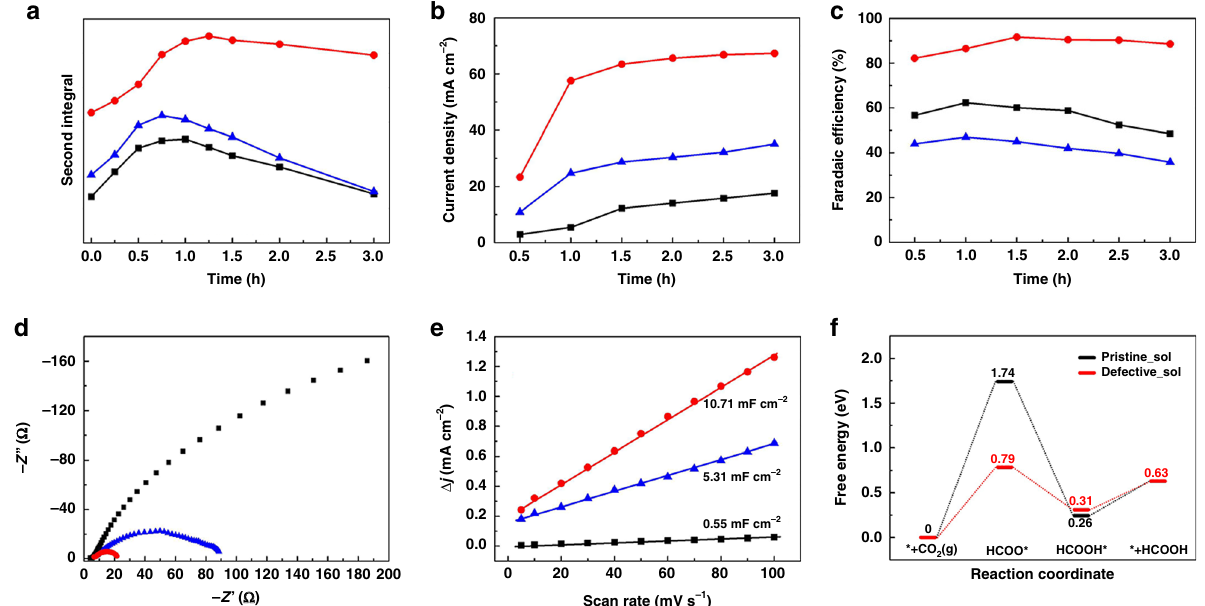
Fig. 4 Comparisons of Cu 2 (L)-t/CP (black lines), Cu 2 (L)-e/Cu (red lines) and HKUST-1-e/Cu (blue lines). a , Plot of second integral of the X-band EPR signals for uncoupled Cu(II) centres at room temperature vs. time of CO 2 electrolysis. b Plot of current density vs. time of CO 2 electrolysis at − 1.8 V vs. Ag/Ag + . c Plot of FE HCOOH vs. time of CO 2 electrolysis at − 1.8 V vs. Ag/Ag + . d Nyquist plots for reduction of CO 2 . e Plot of difference in charging current density vs . scan rates. f DFT calculation of Gibbs free energy of electro-reduction of CO 2 to formic acid over pristine (black lines) and defect Cu 2 (L)-t (red lines) after consideration of solvation